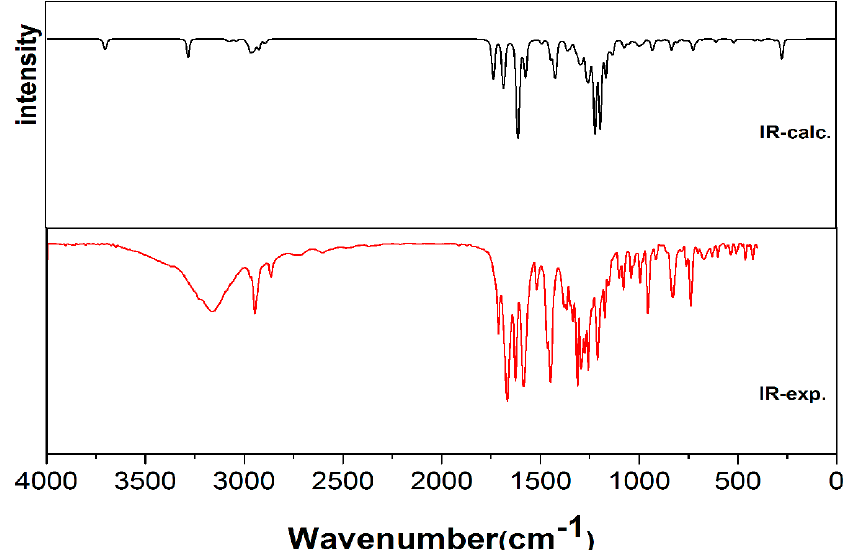
Figure 4. FT − IR and calculated IR for HMD.